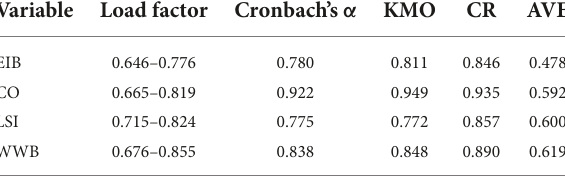
TABLE 2 Reliability and validity of